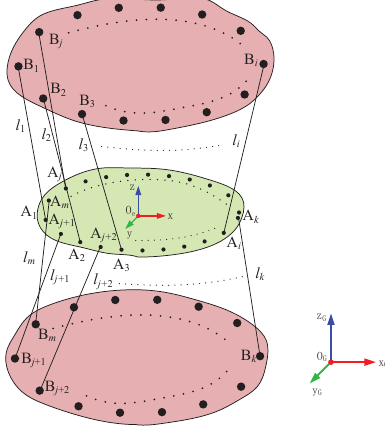
Figure 1. Structural schematics of general cable-driven parallel robots